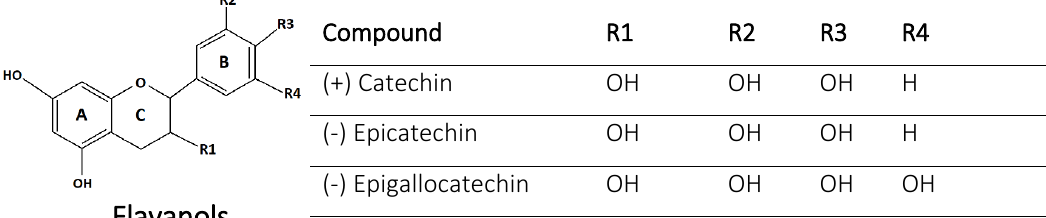
Figure 7. Flavanols: chemical structure, types and substitution positions in the basic skeleton.